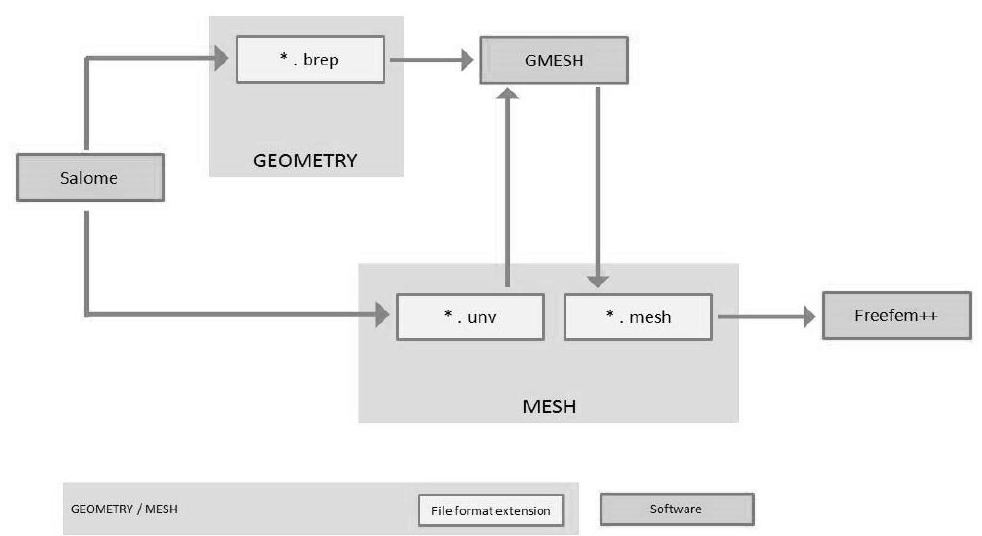
Figure 3. Diagram of the interaction between Salome and FreeFem++.